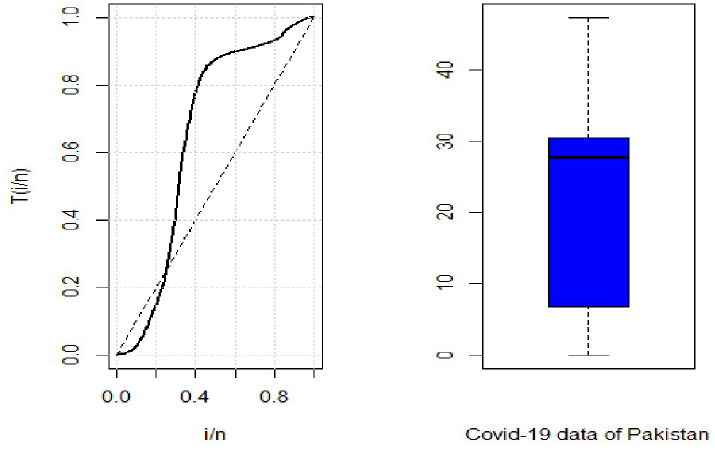
Fig 5. TTT and box plot of Covid-19 data for Pakistan.